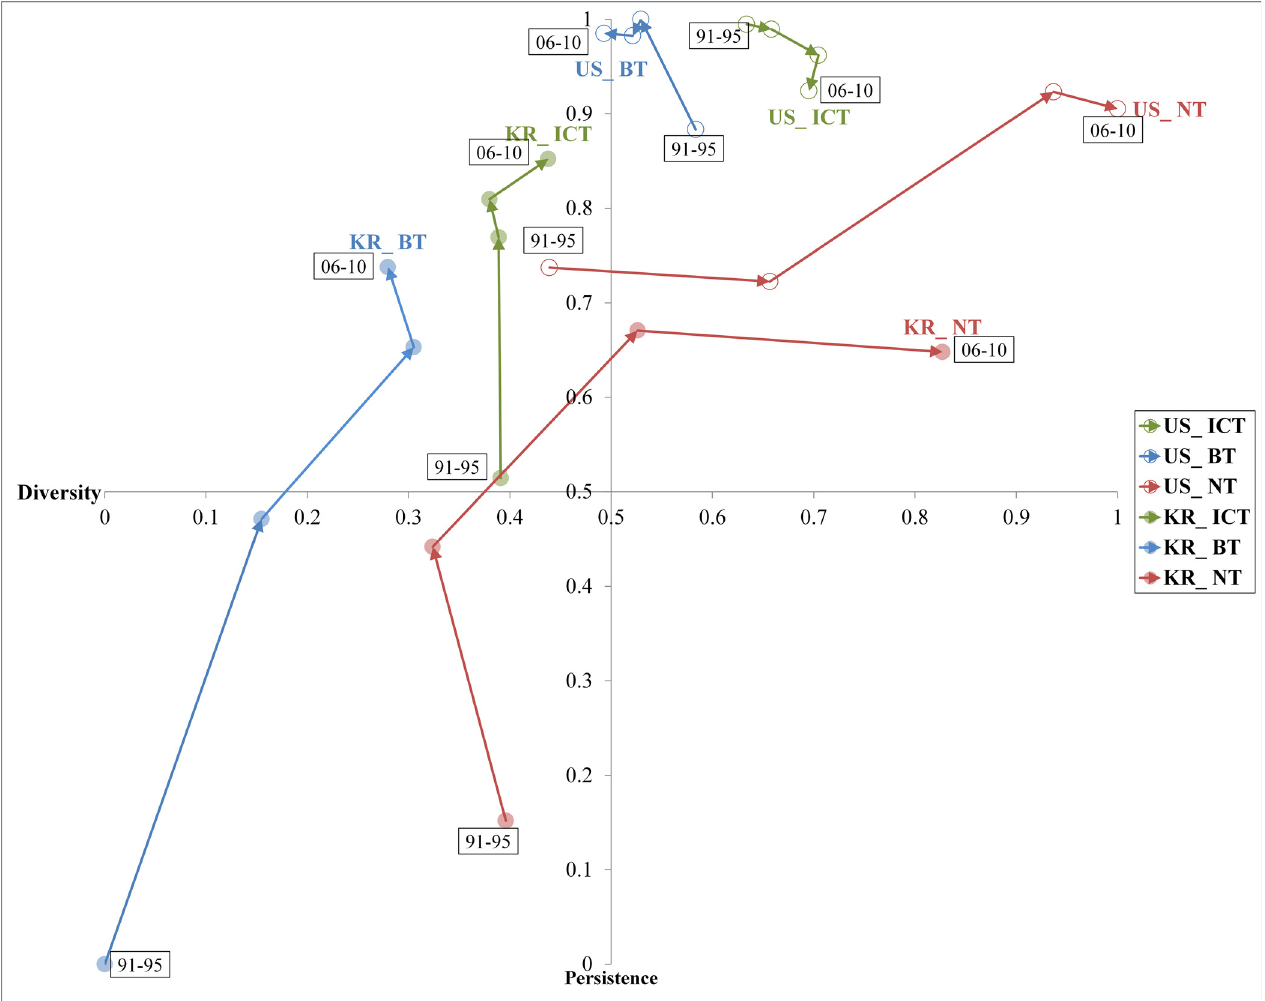
Fig 5. Normalized Diversity and Persistence Patterns in the US and Korea by Time Period. Diversity value range: 0 – 1; Persistence value range: 0 – 1. Quadrant 1: Sustainability zone; Quadrant 2: Specialization zone; Quadrant 3: Improvement zone; Quadrant 4: Diversification zone.